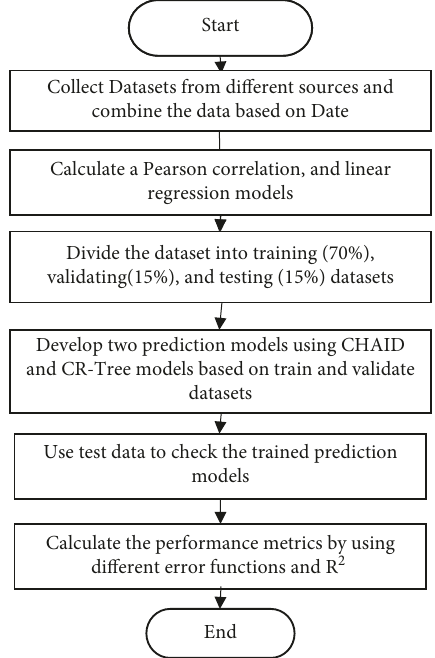
Figure 1: The methodology used to build